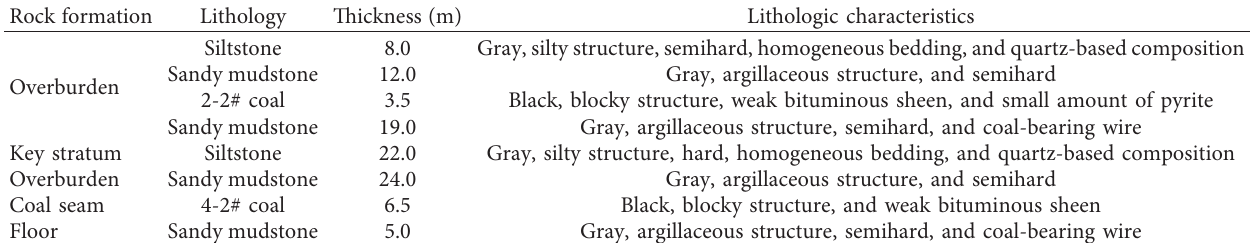
Table 1: Lithologic features.